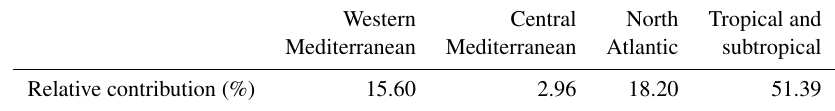
Figure 12. Similar to Fig. 7, but from 6 November at 06:00UTC to 9 November at 06:00UTC. Table 2. Same as Table 1, but from 6 November at 06:00UTC to 9 November at 06:00UTC and over region 2 in Fig.